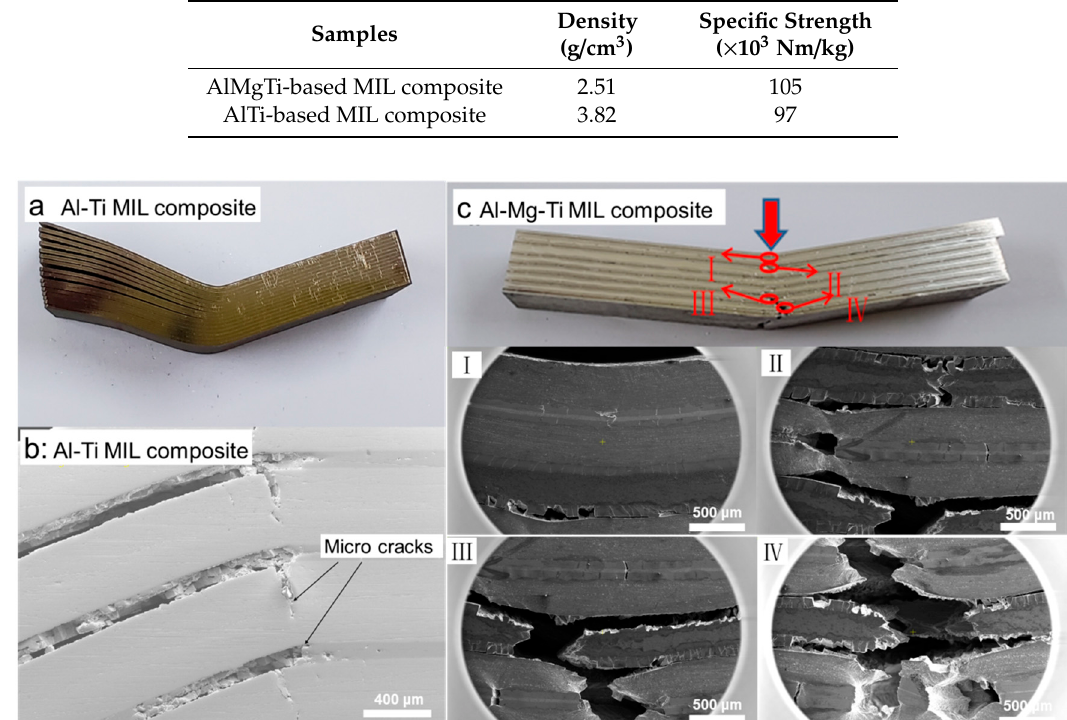
Figure 6. Crack morphology of AlTi-based and AlMgTi-based bending samples: ( a ) The macro morphology of AlTi-based bending sample; ( b ) The micro morphology of AlTi-based bending sample; ( c ) The macro morphology of AlMgTi-based bending sample and four kinds of typical area.